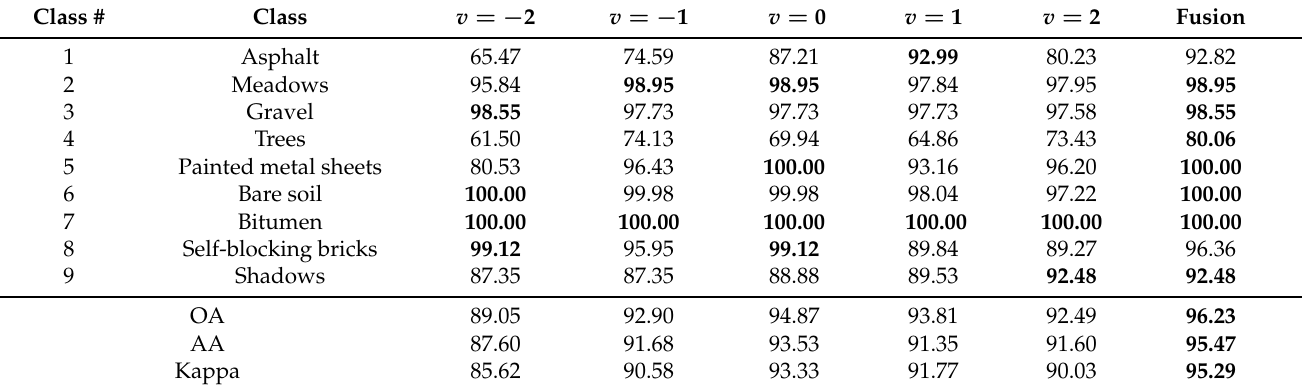
Table 6. Classification performance for different superpixels on the University of Pavia